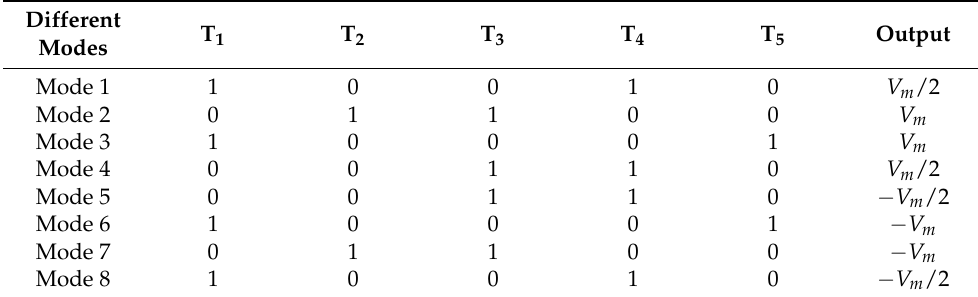
Figure 5. Cycloconverter detailed operation of the eight modes for (1/3) and (1/4) frequency conversion of input frequency. Table 1. Switching states of (1/3) and (1/4) frequency conversion of Input Frequency of the pro- posed